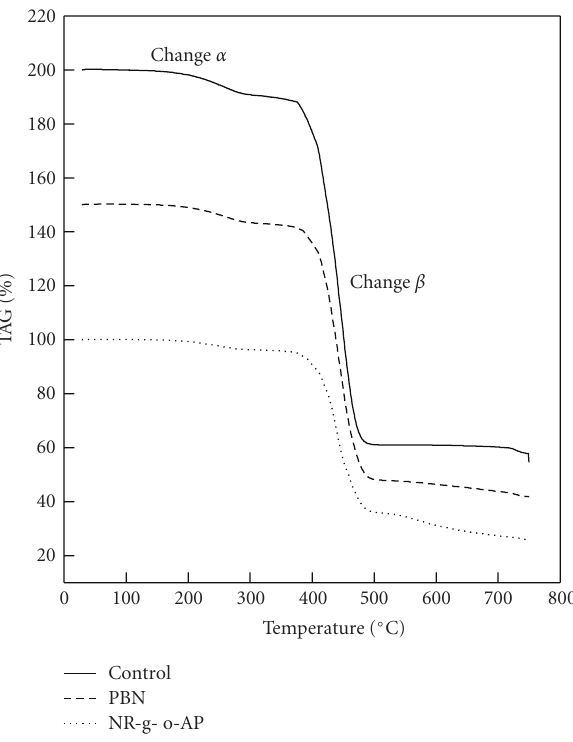
Figure 11: TGA thermogram for for NBR vulcanizates containing PBN, NR-g- o -AP, and control vulcanizate. Table 4: The activation energy of NBR vulcanizates containing PBN, NR-graft- o -AP, and control